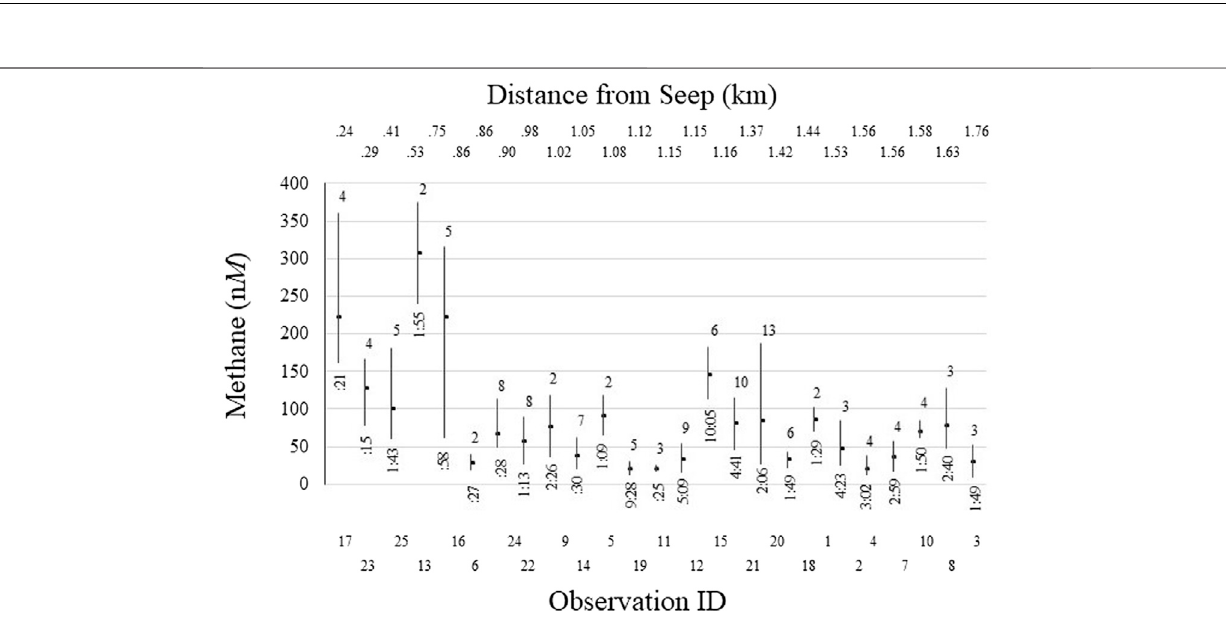
Frontiers in Earth Science |